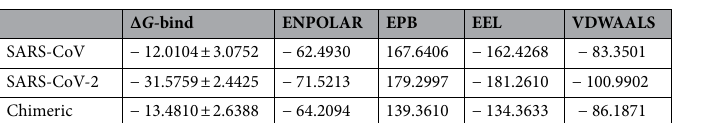
altering each of these residues lead to reduce the binding affinity in SARS-CoV-2 and the lowest binding affinity was observed for Phe456Ala substitution.